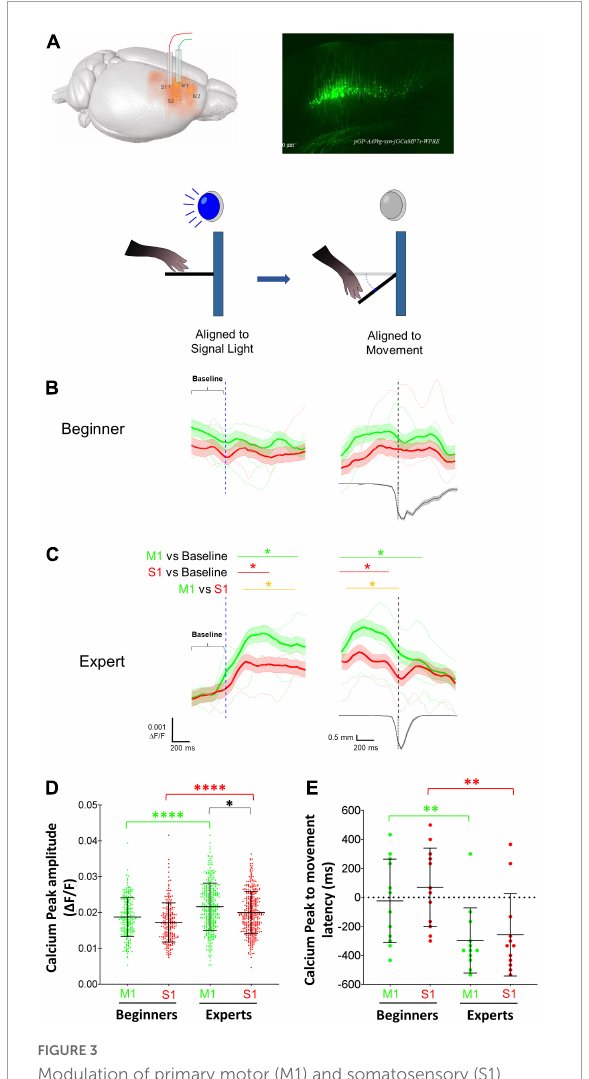
FIGURE3 Modulation of primary motor (M1) and somatosensory (S1) corticospinal (CSp) neurons during the execution of forelimb movements. (A) Schematic diagram showing the location of the optical fibers into M1 and S1 cortices and the expression in CSp neurons of the GCaMP7s produced by the injection of the retrograde virus pGP-AAVrg-syn-jGCaMP7s-WPRE. Calcium activity photometry for CSp neurons was recorded in all trials of all learning sessions and the calcium fluorescent changes were aligned to the cue (light signal) and to the movement (threshold reached by the lever). (B) Grand average (mean: thick lines; SE: shaded areas) and individual mice averages (thin lines) of calcium fluorescence changes of M1 (green) and S1 (red) CSp neurons aligned to the signal light and movement (vertical dashed lines) computed for successful trials in the first four sessions (beginners). The lower trace is the averaged displacement of the lever computed for all the trials in the photometry sessions. (C) The same as (B) but photometry signals were recorded in the last four training sessions (experts). Horizontal green (M1 CSp) and red (S1 CSp) lines and asterisks above the traces indicate the time intervals in which fluorescence values increase significantly compared with baseline. Yellow line and asterisks indicates the time intervals in which M1 and S1 CSp fluorescent values distributions are significantly different between each other (* p < 0.05; AUROC